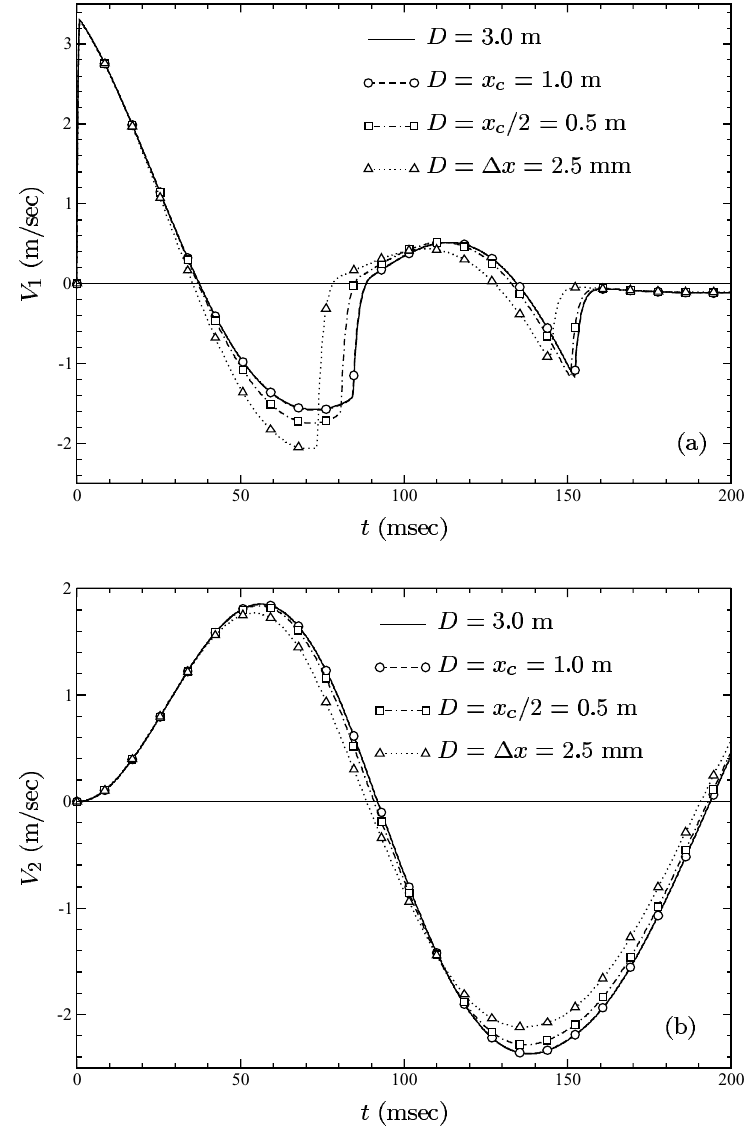
Fig. 8. (a) V 1 - and (b) V 2 -response histories for M 2 /M 1 = 1 , demonstrating the performance of truncated CAFE meshes.